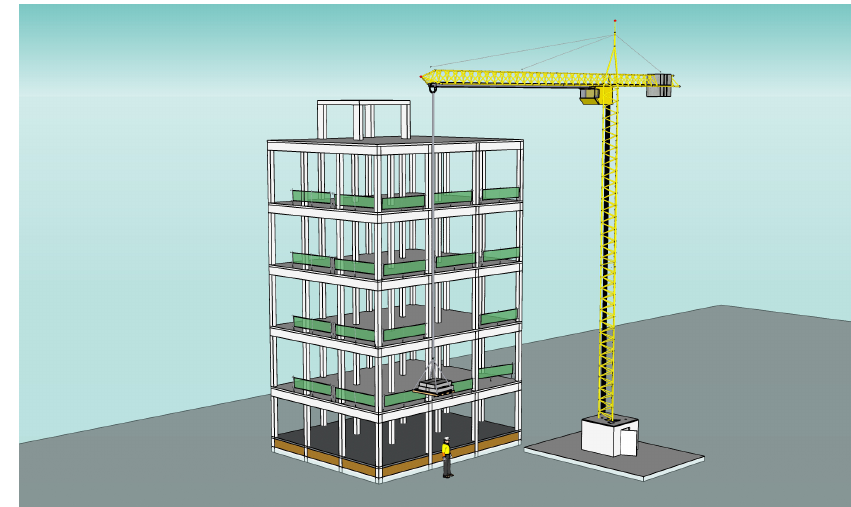
Figure 6. Visual example of material loading tasks: Very High risk.